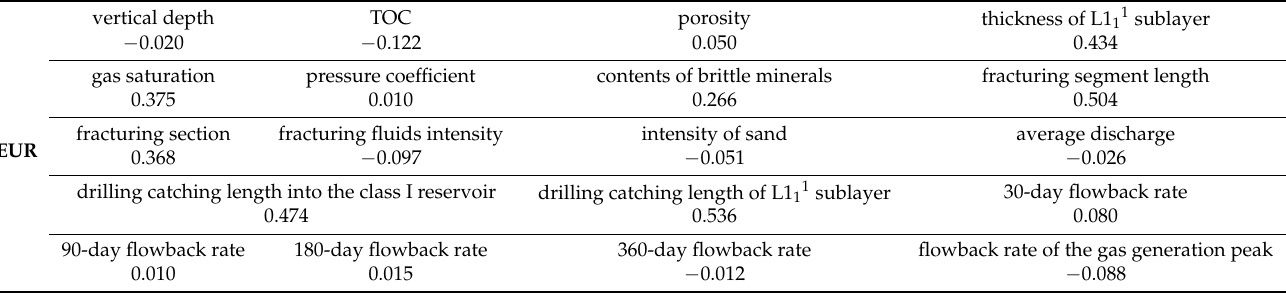
Table 3. Pearson correlation coefficient table.